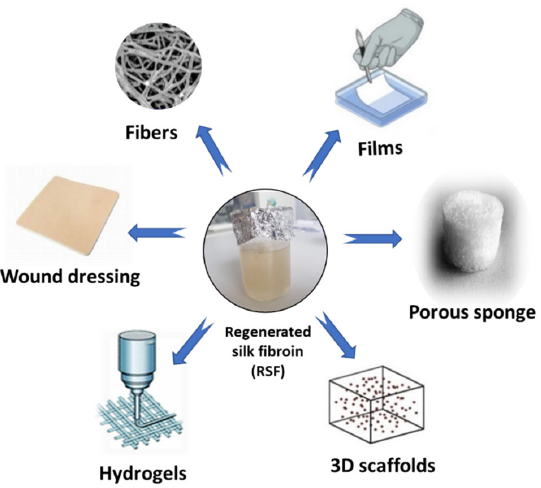
Figure 4. SF as a functional biomaterial for the tissue engineering field.